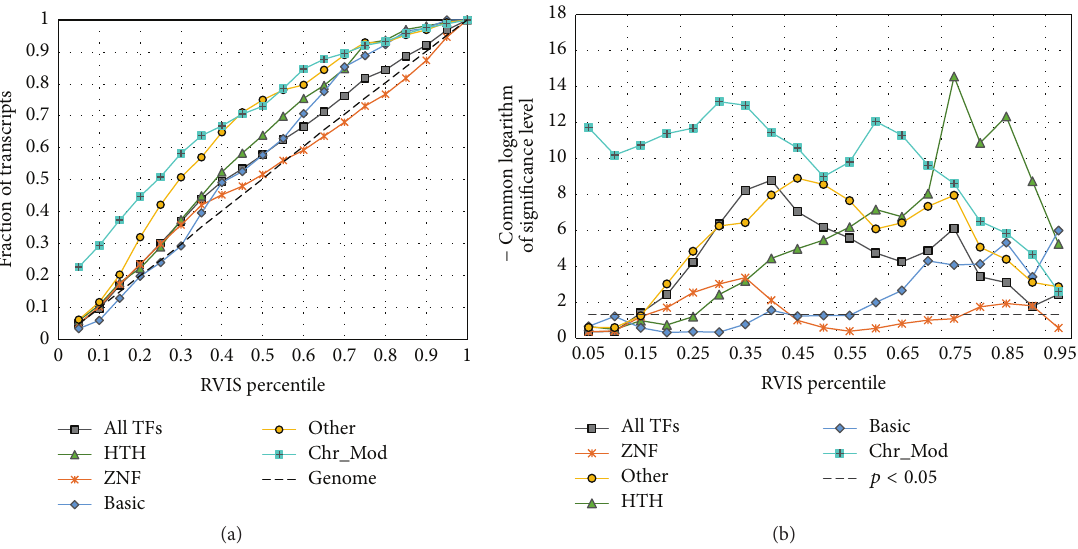
Figure 6: Comparison of Residual Variation Intolerance Score (RVIS) [21] percentiles for six groups of human genes with percentiles for the whole-genome dataset. (a) Cumulative percentage plots for the RVIS percentiles for six groups of human genes and for the whole-genome dataset. (b) Significance of the 𝑡 -test ( 𝑦 -axis) where RVIS percentiles in six groups were compared with those for the whole-genome dataset as a function of the RVIS percentile threshold ( 𝑥 -axis). The 𝑡 -test was applied as described in Section